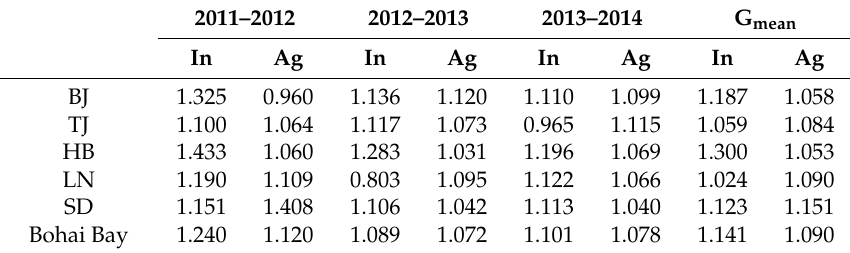
Table 2. Changes in NMWUPI of industry and agriculture, 2011–2014.